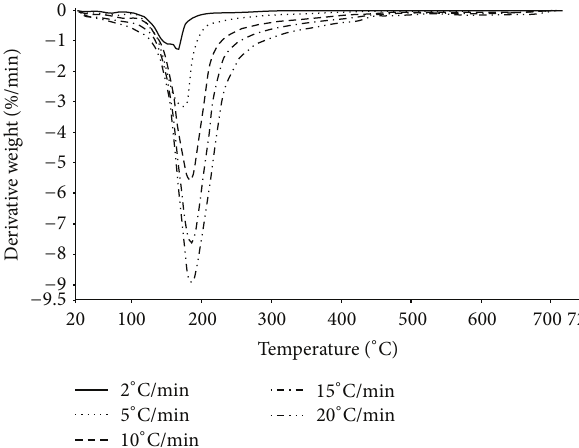
Figure 8: DTG curve of synthesized pure mcallisterite.